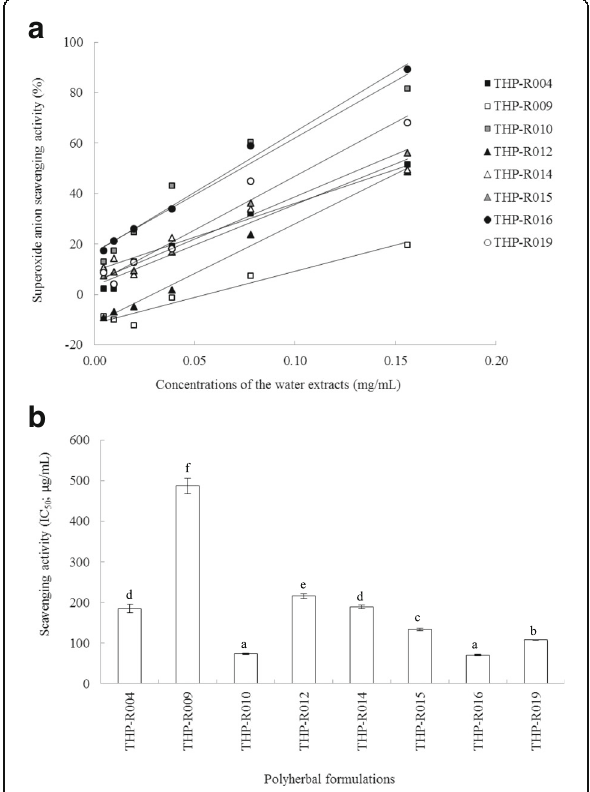
Fig. 3 Anti-peroxyl radical activity, fluorescence decay curves of fluorescein in the presence of THP-R016 water extract ( a ) and the reference antioxidant trolox ( b